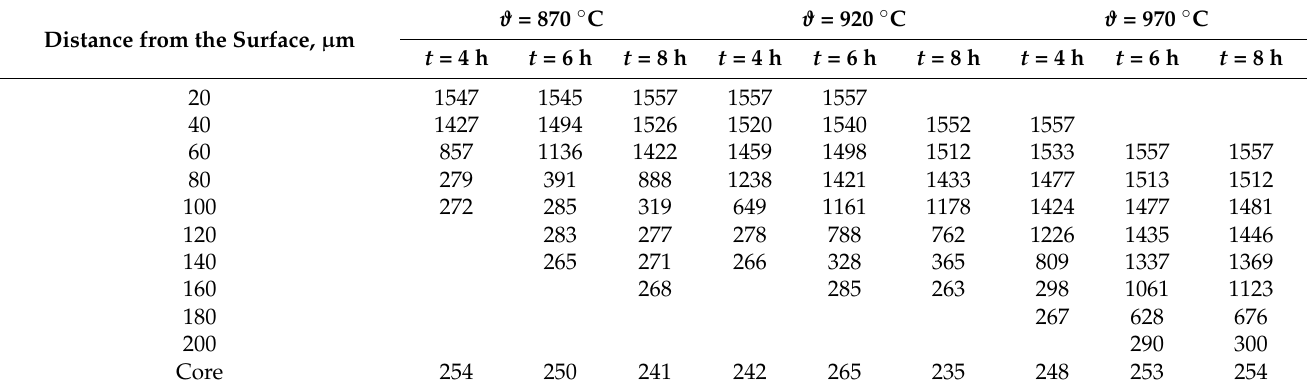
Table 5. Cross-sectional microhardness of the boride layer on C70W2 steel, HV 0.1. Distance from the Surface, µ m